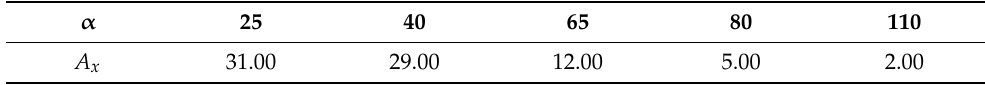
Table 3. A x values based on the spray angle.